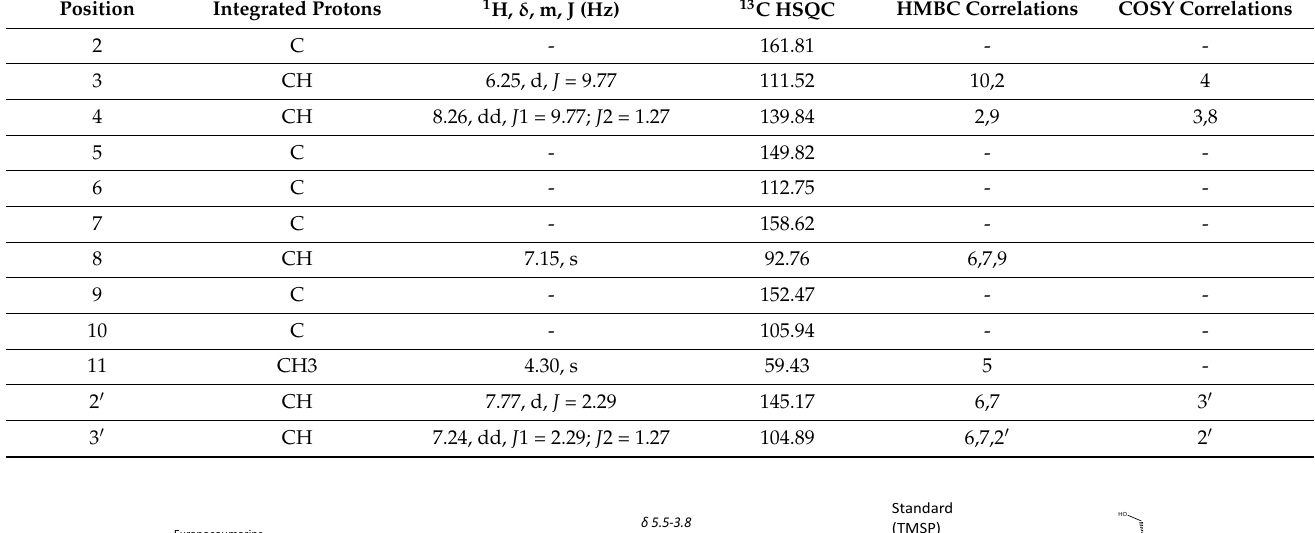
Table 3. NMR spectral references of bergapten.